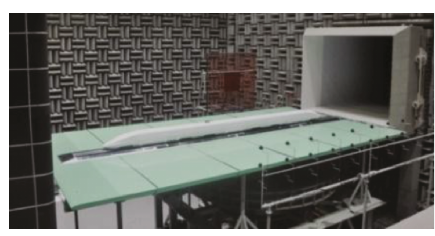
Δ (units: m) and (b)